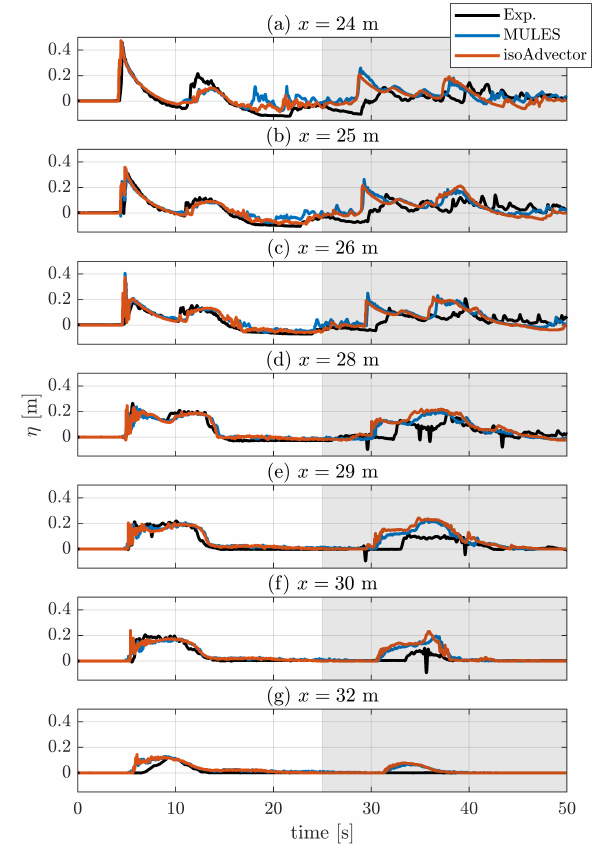
Figure 6. Comparison of surface elevation η between the experiments and two models, where the different panels show different cross-shore locations. The last 25 s are shown with a grey background.